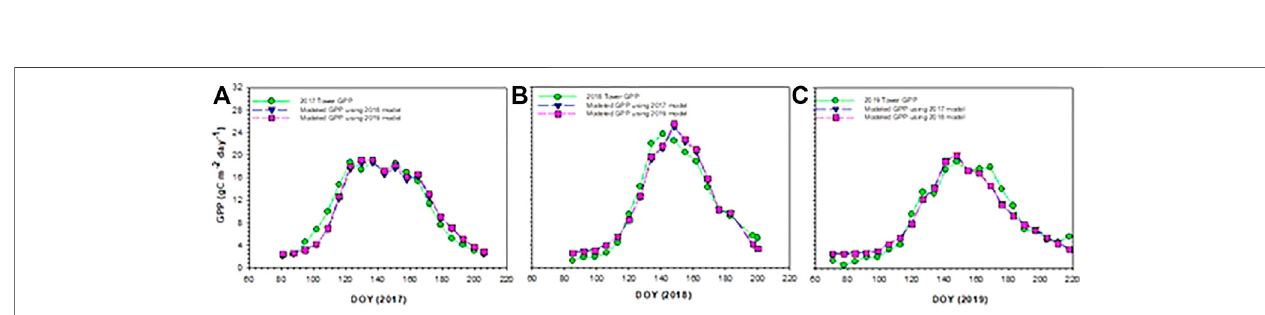
FIGURE 9 | Weekly averages of eddy covariance tower-based gross primary production (GPP) plotted against predicted GPP using SAVI-based GPP models for 2017 (A) , 2018 (B) , and 2019 (C) .